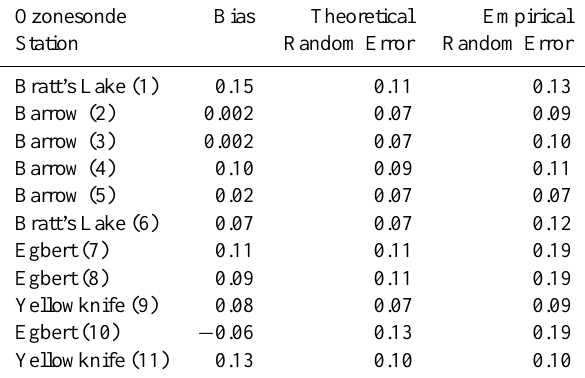
Table 3. Mean bias, theoretical and random errors for V003 TES data comparisons.